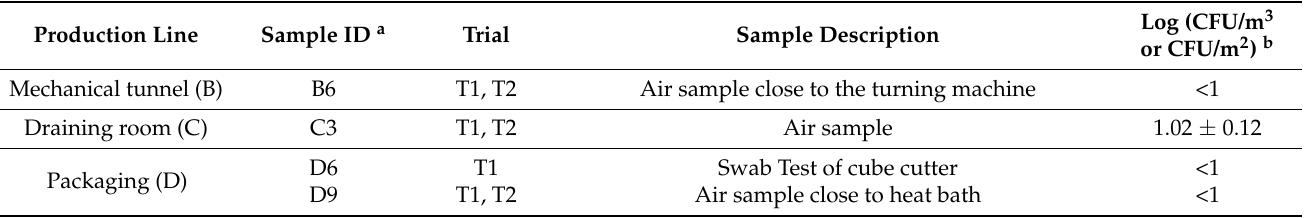
Table 2. Viable counts of yeasts in environmental samples from white-brined cheese